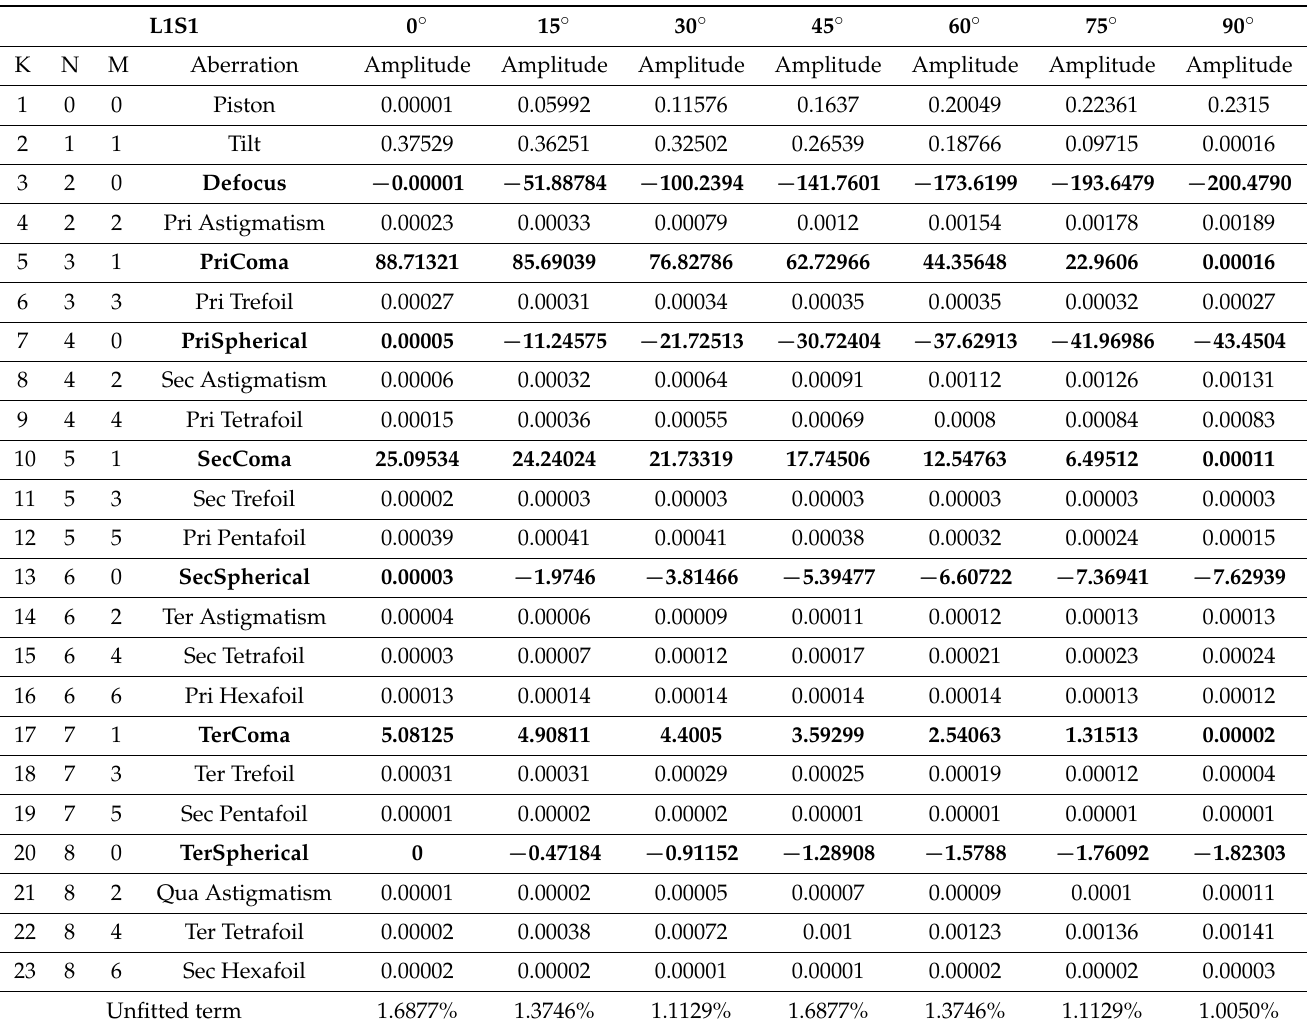
Table 7. Zernike polynomial fitting of L1S1